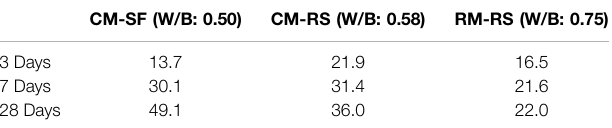
TABLE 3 | Summary of compressive strength (MPa) of mixes. CM-SF (W/B: 0.50)